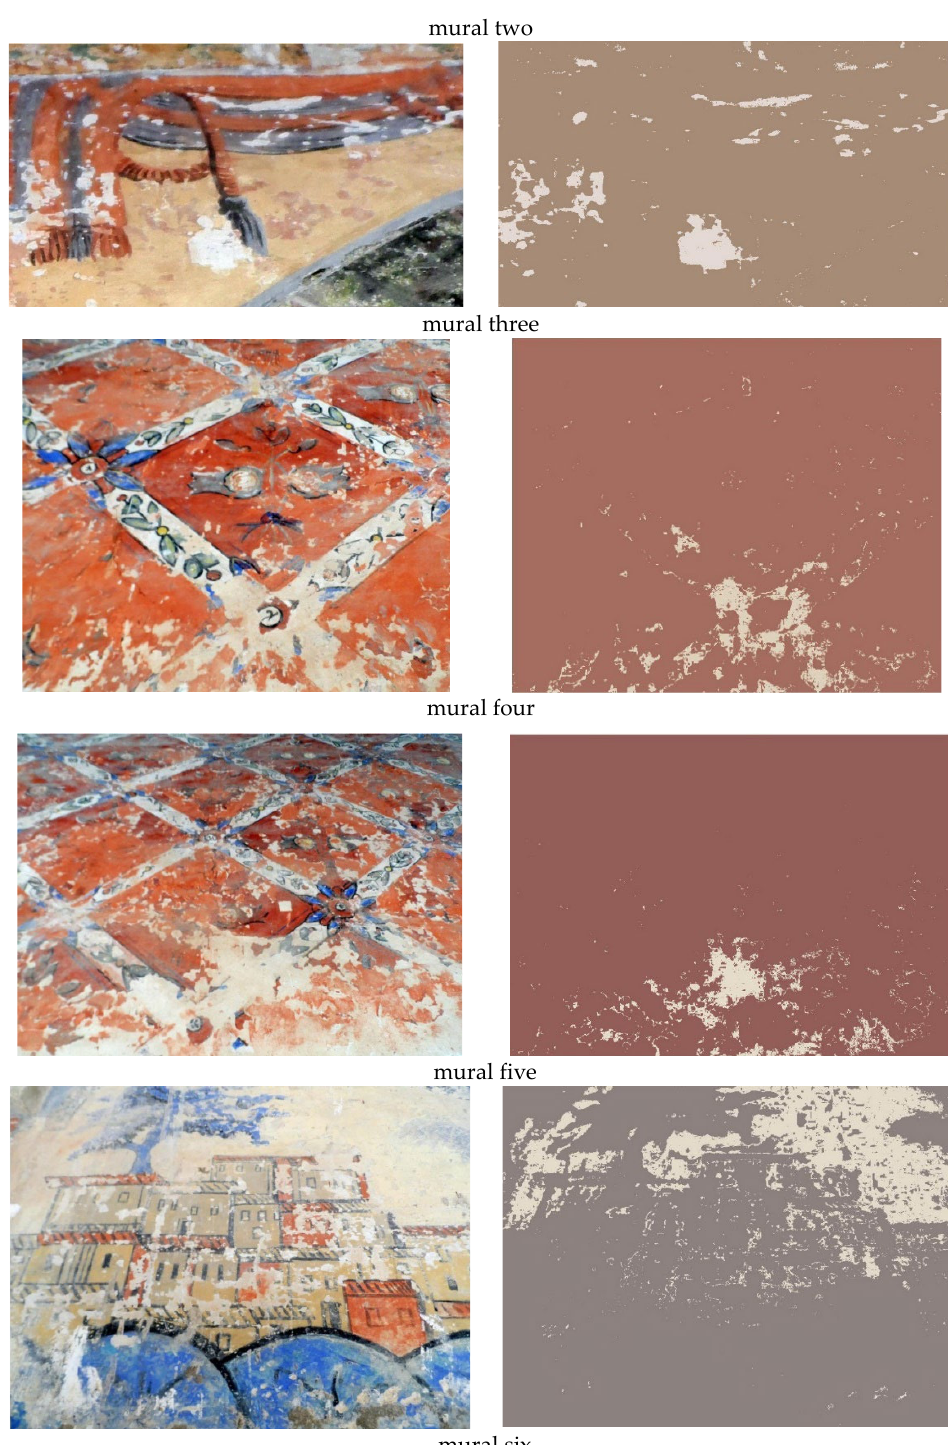
Figure 12. The original and the output of murals 2, 3, 4, 5, and 6. The MD approach successfully extracted the lacunae regions.